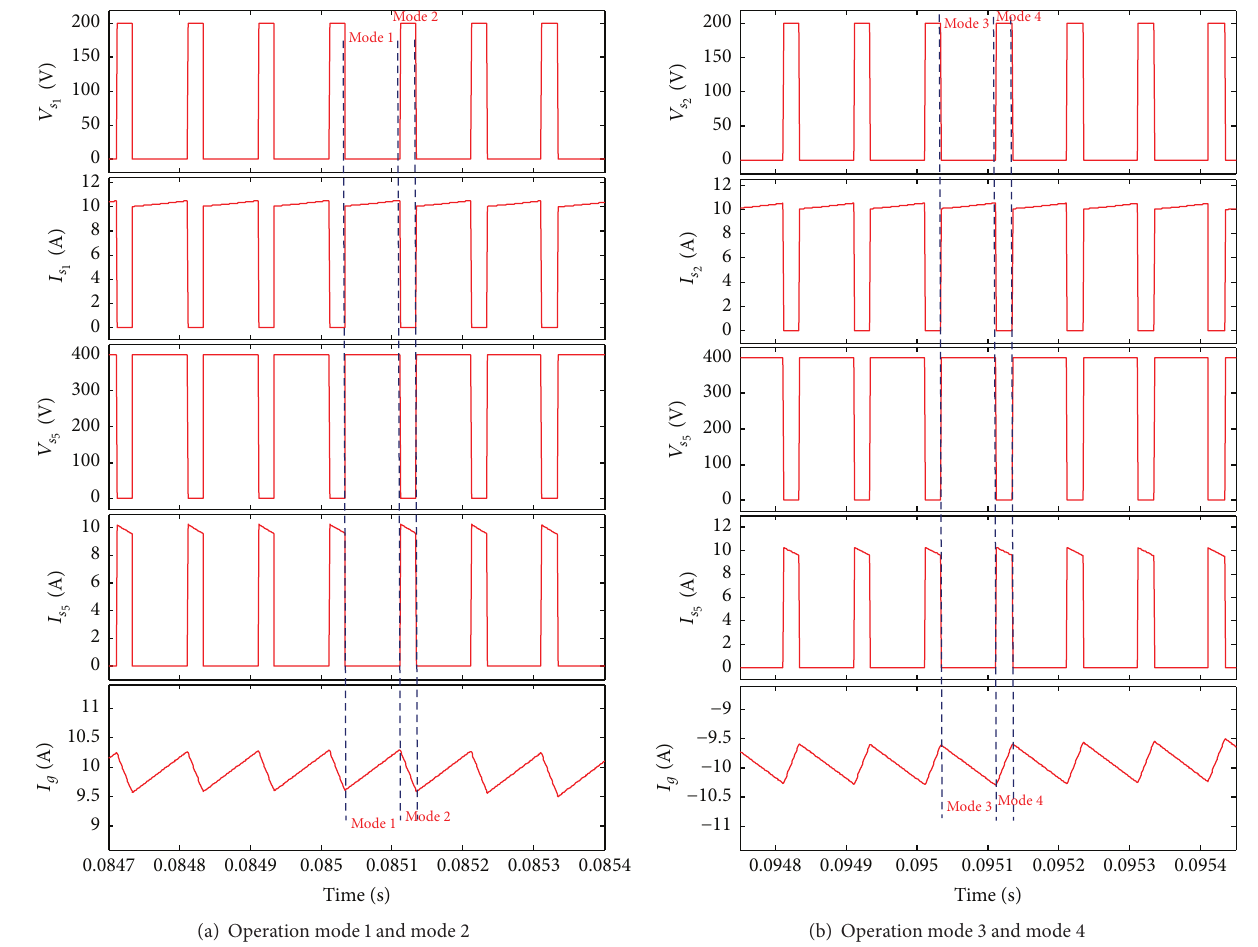
Figure 5: Simulation results showing the operation of the